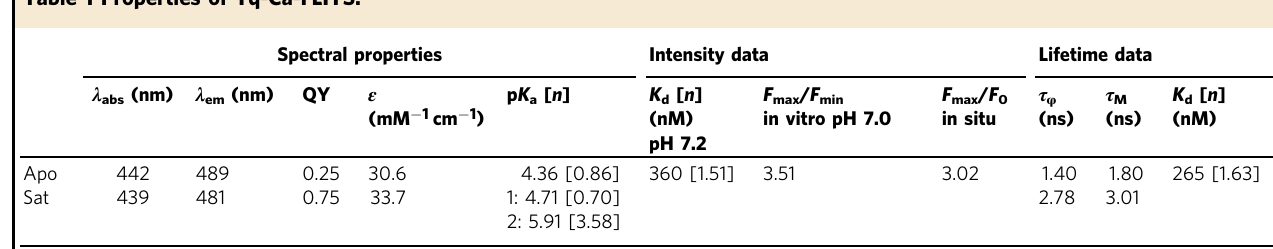
Table 1 Properties of Tq-Ca-FLITS.